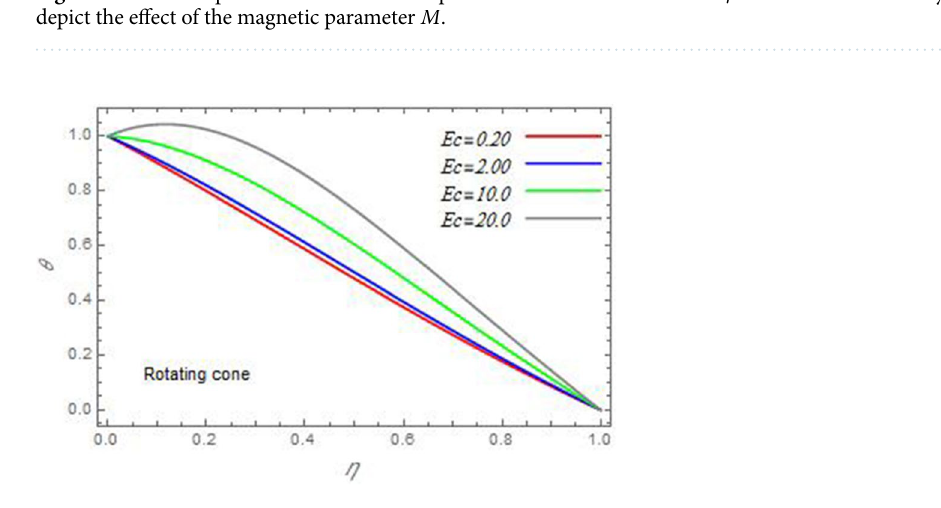
Figure 21. The temperature distribution θ is plotted versus the axial variable η in the case of stationary disc to depict the effect of the Eckert number Ec